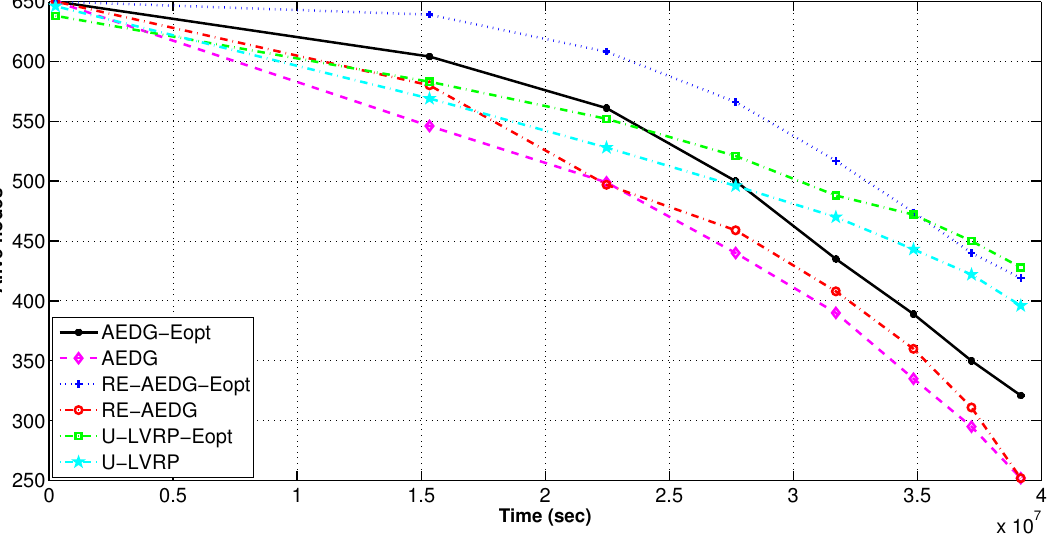
Figure 12. Number of alive nodes per interval in comparison to energy optimized protocols.